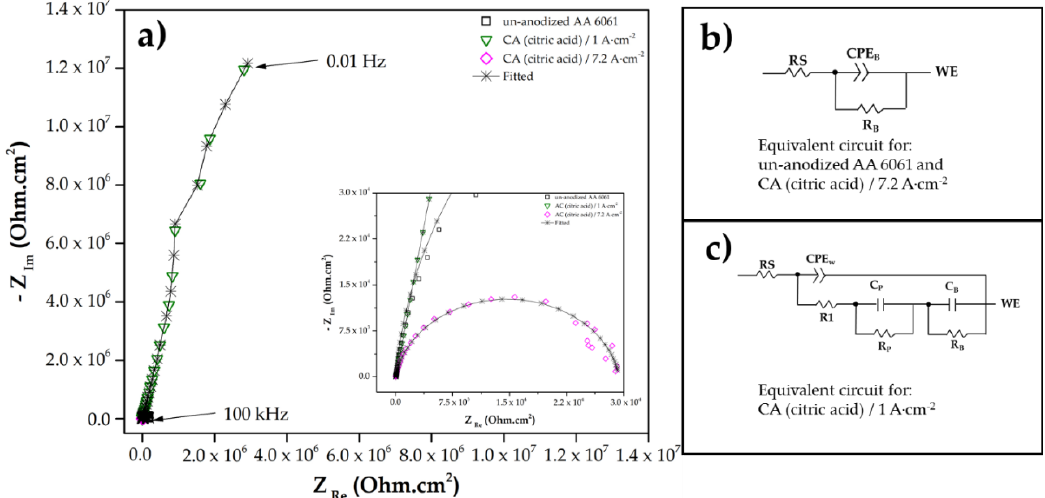
Figure 3. ( a ) Nyquist diagrams for the un-anodized AA 6061 and samples anodized in citric–sulfuric acid, evaluated in 3.5 wt.% NaCl solution; ( b , c ) equivalent circuits.